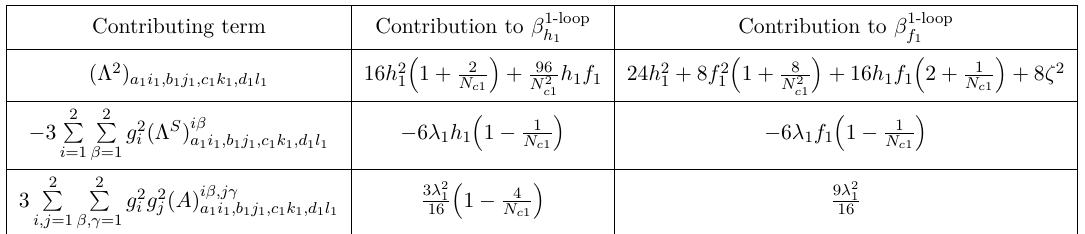
Table 1. Contribution of different terms to β 1-loop